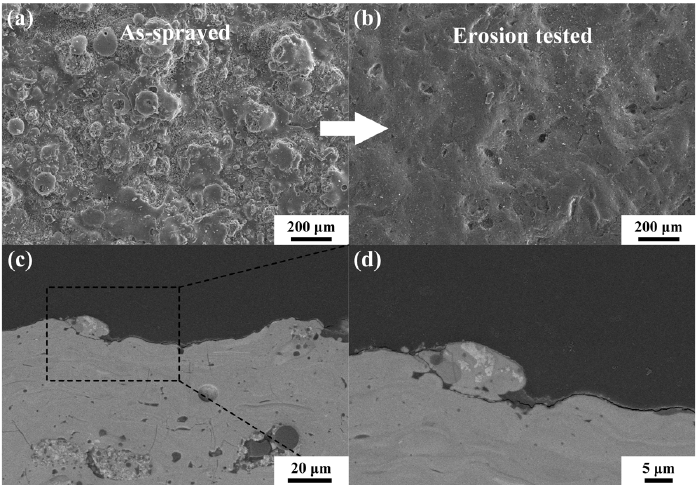
Figure 6. Surface morphologies of Al 2 O 3 -GAP coating ( a ) as-sprayed and ( b ) erosion tested and ( c , d ) cross-sectional morphologies of Al 2 O 3 -GAP coating after erosion test.